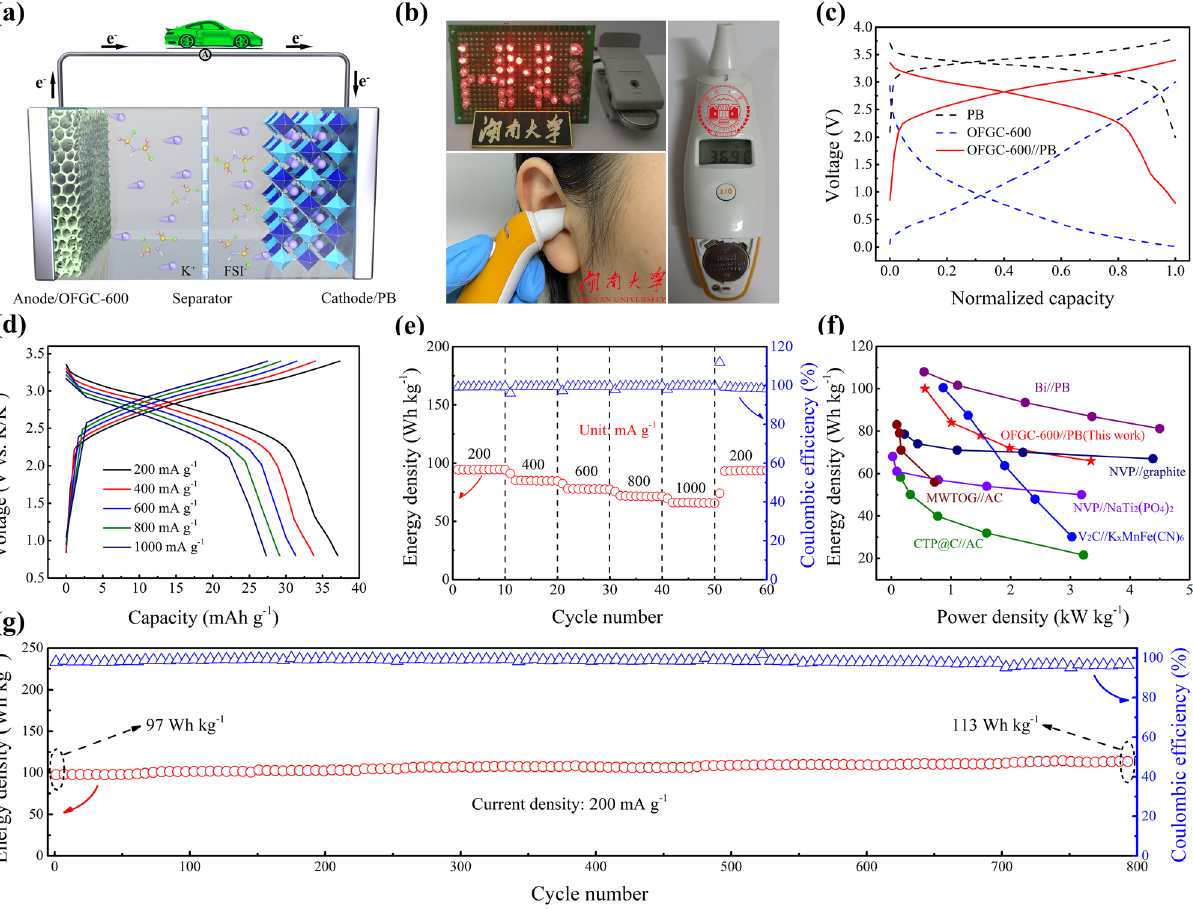
Fig. 6 a Schematic illustration of the discharge mechanism of the OFGC-600//PB full cell. b The devices of an LED bulb with “HNU” and the ear thermometer driven by the full cells. Electrochemical performances of the full cells. c The charge/discharge curves of PB, OFGC-600, and OFGC-600//PB. d – e The rate capability at different current densities from 200 to 800 mA g −1 . f Ragone plot of OFGC-600//PB full cell com- pared with the reported articles. g Cycling performance at a current density of 200 mA g